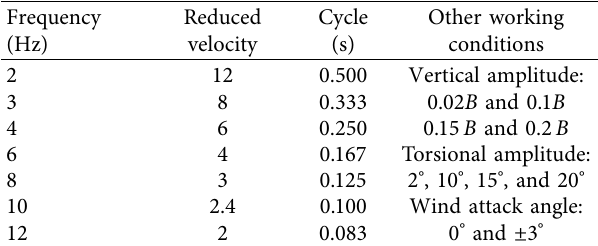
Table 3: Operation